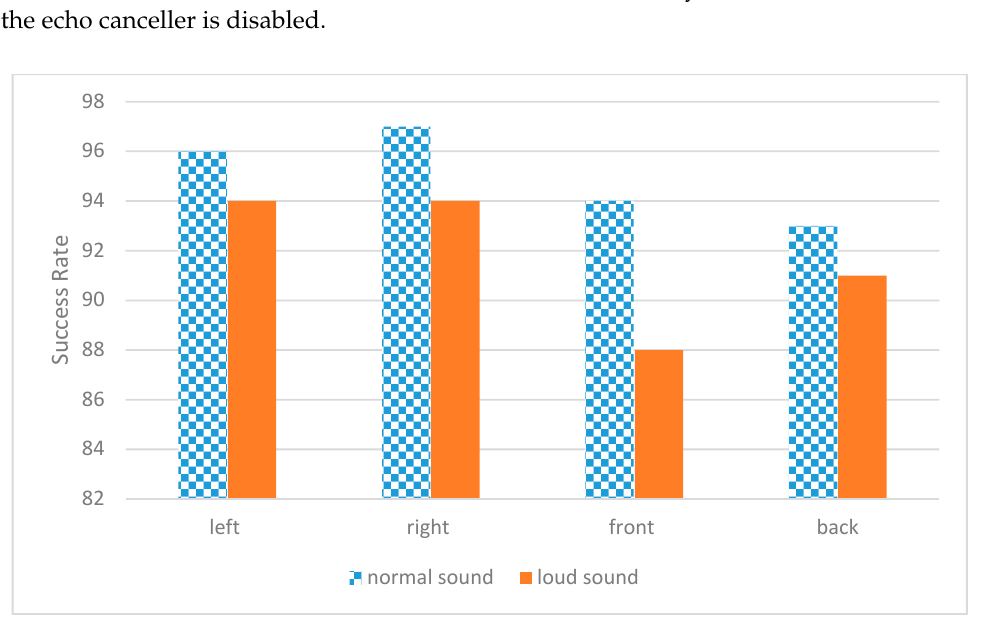
Figure 7. Success rate of loud and normal sound perceptions. Table 5. Success Rate of 4 and 8 directions.